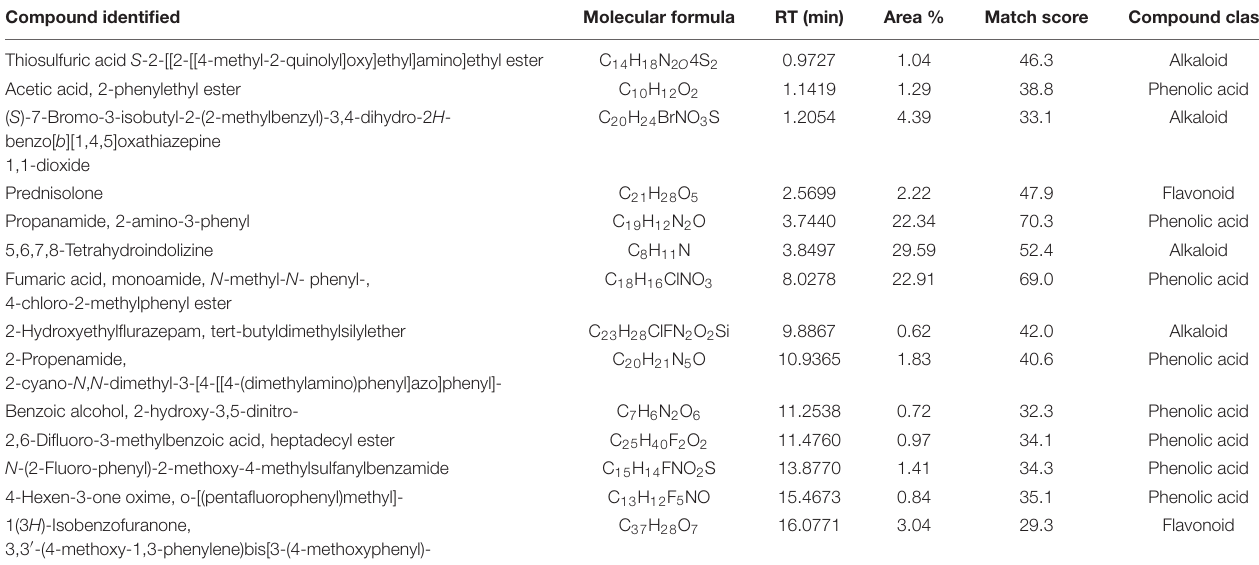
TABLE 5 | Most abundant compounds identified by LC-MS in wheat extract.